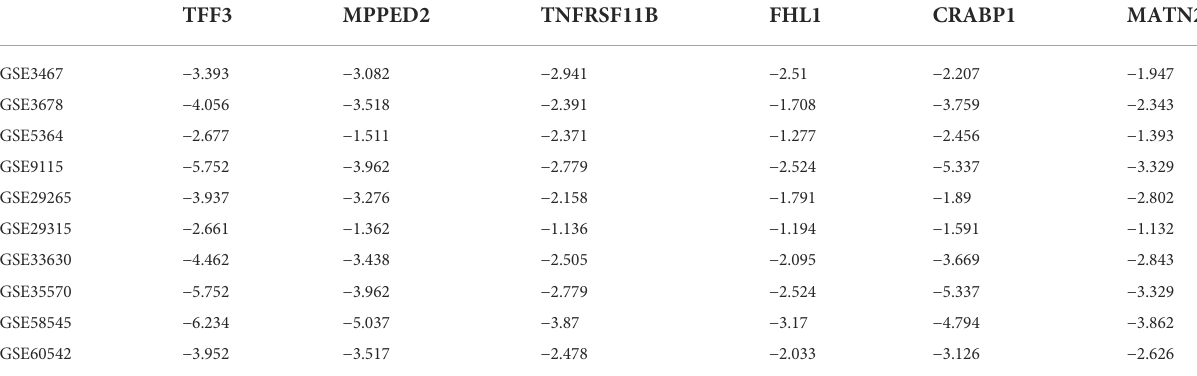
TABLE 3 Expression fold change (log2) of differentially downregulated genes (DDG) in papillary thyroid carcinoma. TFF3 MPPED2 TNFRSF11B FHL1 CRABP1